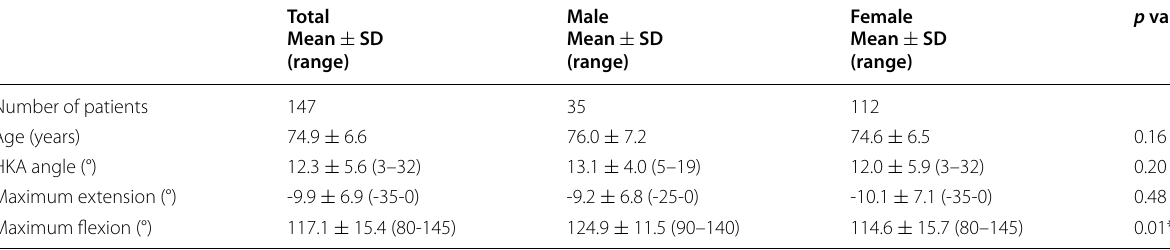
SD standard deviation, HKA angle Hip-knee-ankle angle *Significantly different among genders ( p <0.05)